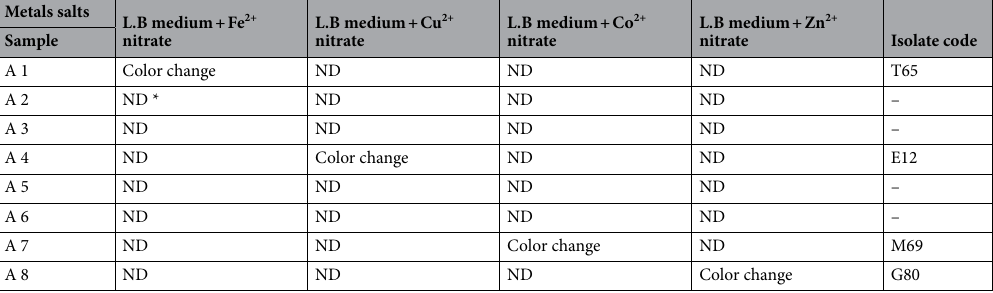
Table 2. Isolation of metals reducing bacteria from water samples. * ND Not detected.